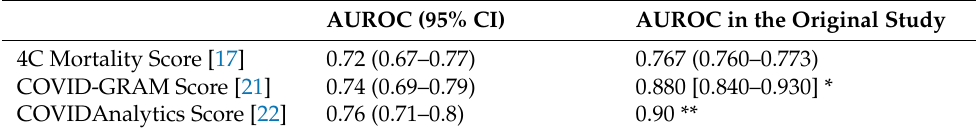
Table 3. Comparative performance of the three prognostic scores in our study and in their original cohorts.